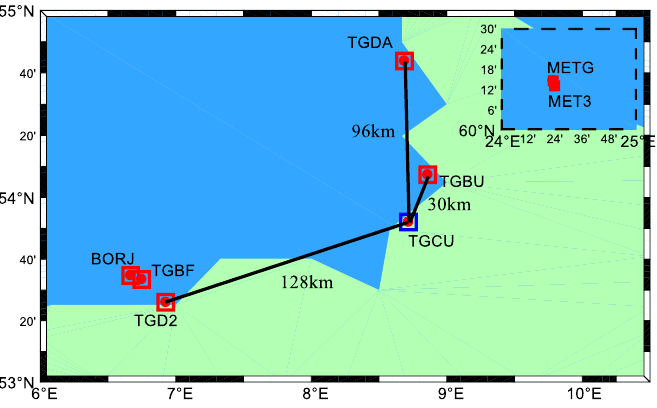
Figure 1. Distribution of the selected IGS/MGEX station. Table 1. Information of the selected stations.